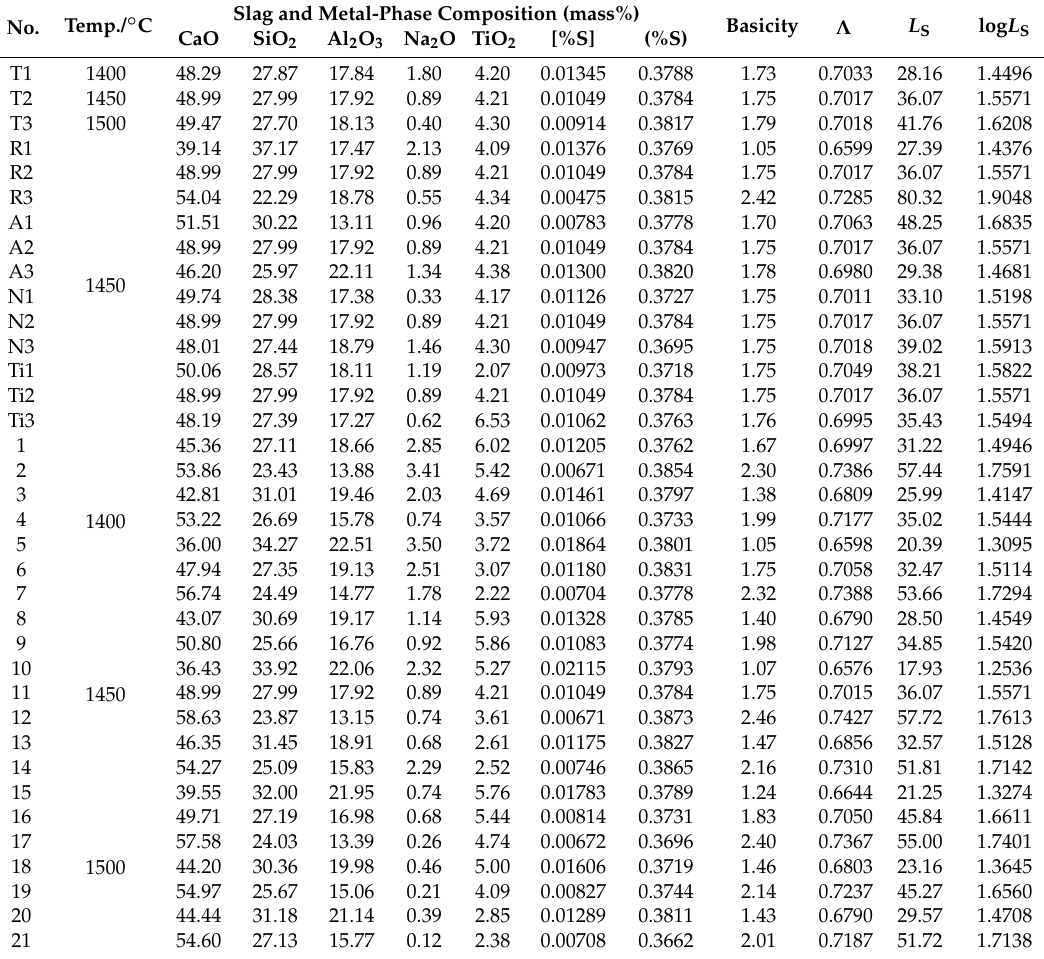
Figure 3. The change of sulfur content in the metal with time. Table 1. Experimental data after equilibration.